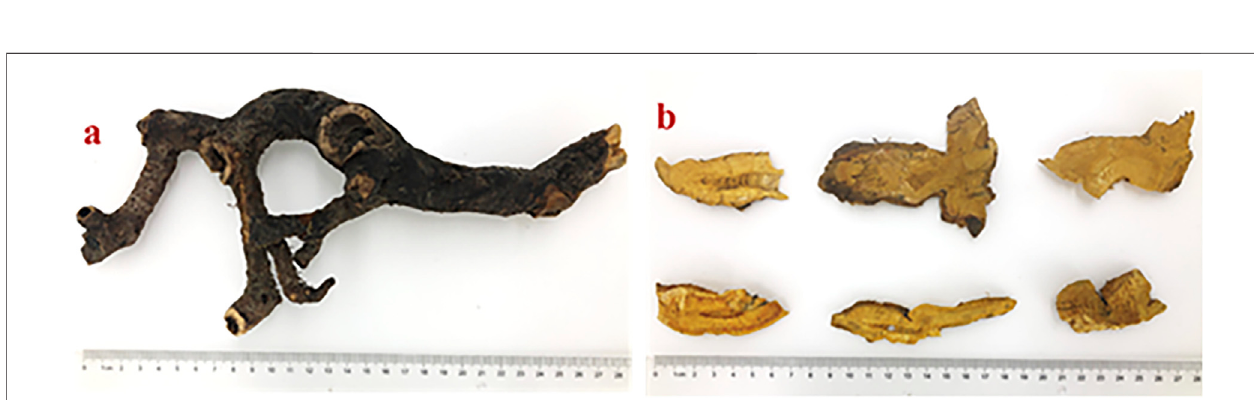
Frontiers in Pharmacology |